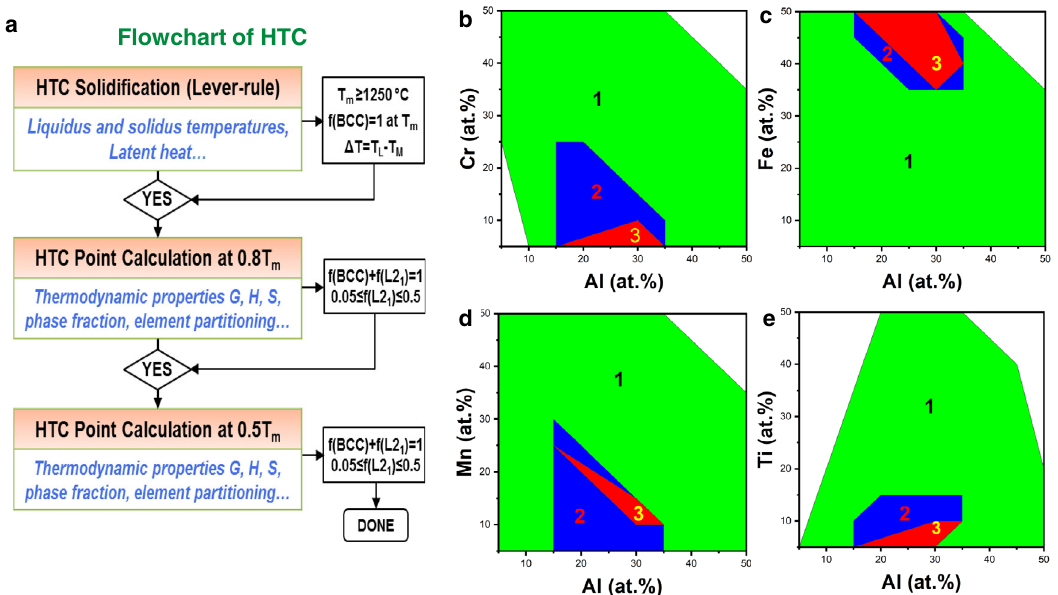
Fig. 1 High-throughput screening optimal alloy compositions in the Al – Cr – Fe – Mn – Ti system. a Flowchart of the current HTC. b Al – Cr projection. c Al – Fe projection. d Al – Mn projection. e Al – Ti